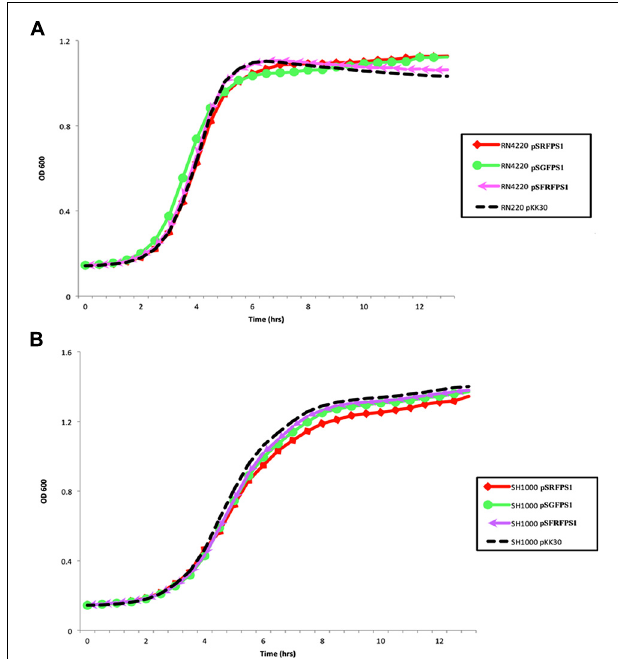
FIGURE 2 | (A) Growth of fluorescent strains containing pSGFPS1, pSRFPS1, and pSFRFPS1 in (A) RN4220 and (B) SH1000 in TSB media without antibiotic. Growth of pKK30 vector without inserts is shown in black.